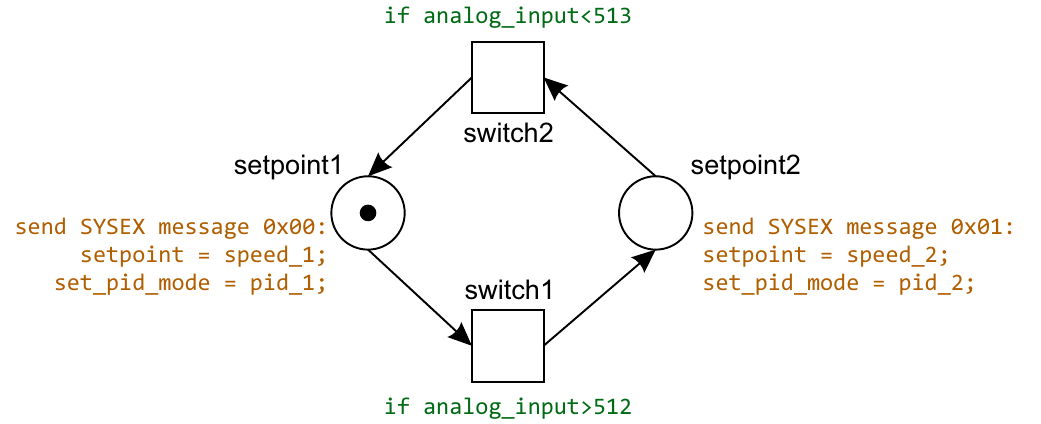
Figure 18. Control scheme for hybrid system using